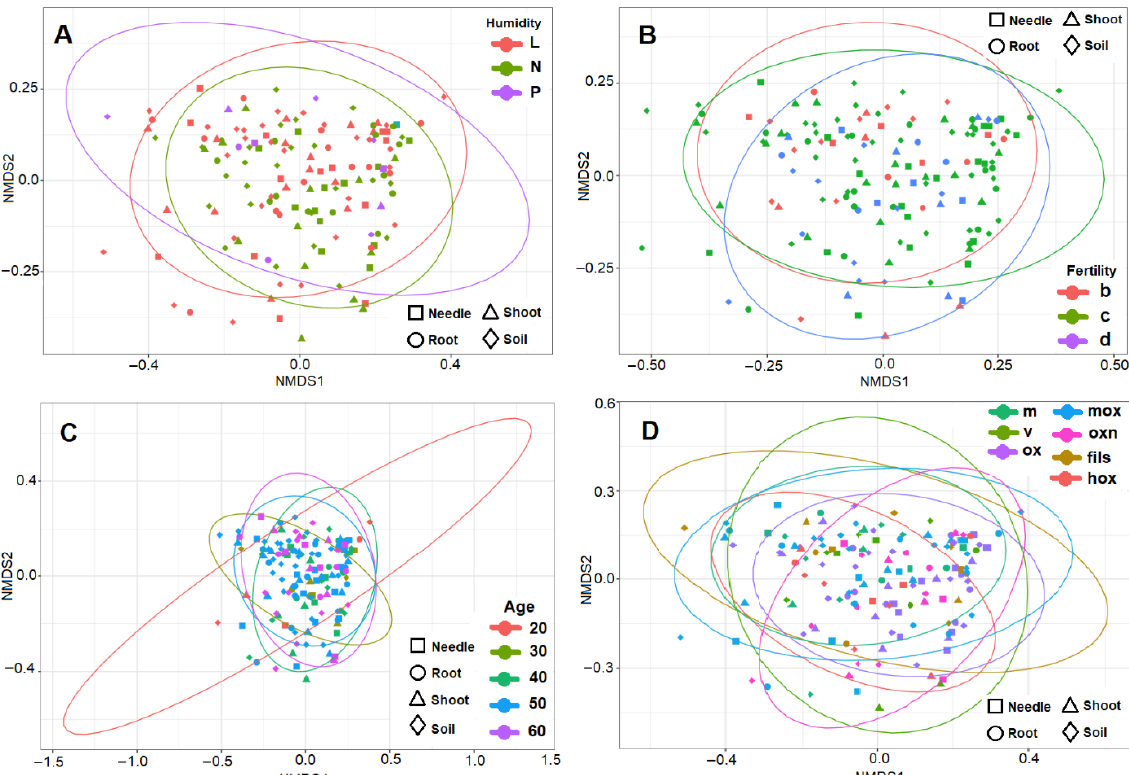
Figure 9. Nonmetric multidimensional scaling (NMDS) of fungal communities detected in needles, shoots, roots, and the rhizosphere soil of Picea abies . For each substrate, each point in the diagram represents a single sampling site. NMDS shows the impact of soil moisture ( A ), soil fertility ( B ), stand age ( C ), and vegetation type ( D ) on the composition of fungal communities.